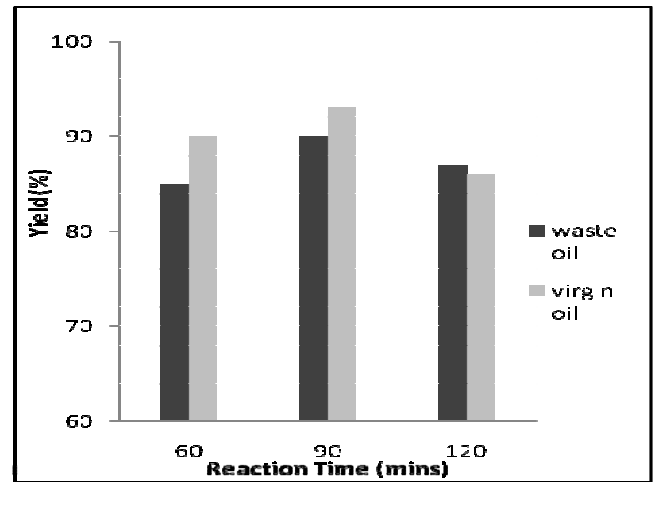
Figure 4. Effect of reaction time on FAME yield via the mechanical stirring under a 6:1methanol/oil ratio, at 60 °C and catalyst concentration of 1%wt of